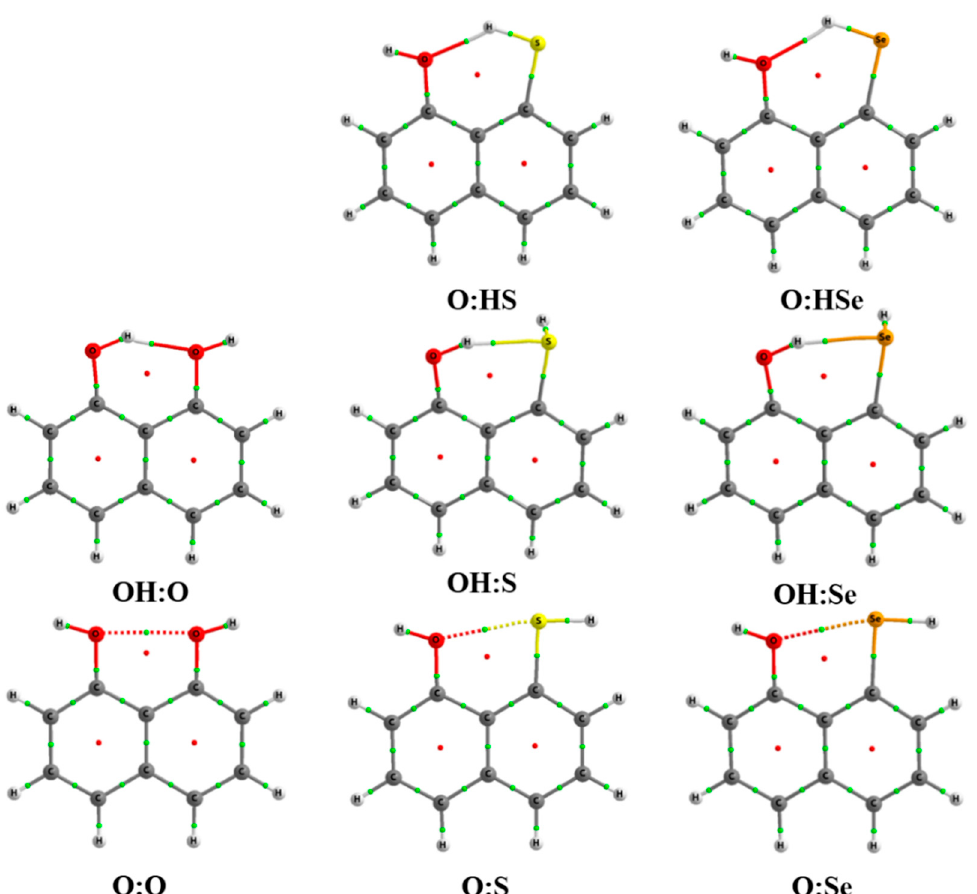
Figure 1. Molecular graph for all the compounds with a single interaction at the MP2/aug-cc-pVDZ computational level. Green and red dots correspond to bond and ring critical points, respectively.